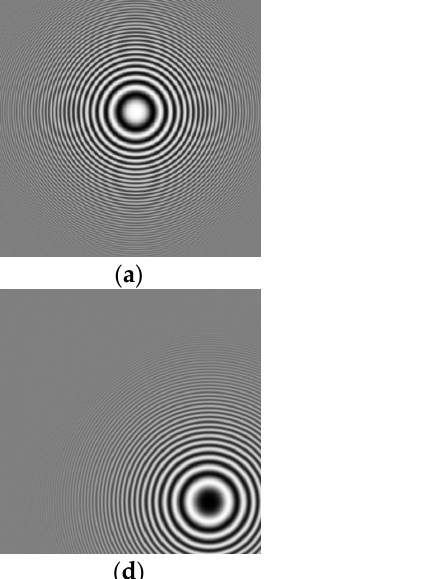
field diffracted from three pinholes illuminated by a plane wave in an optical